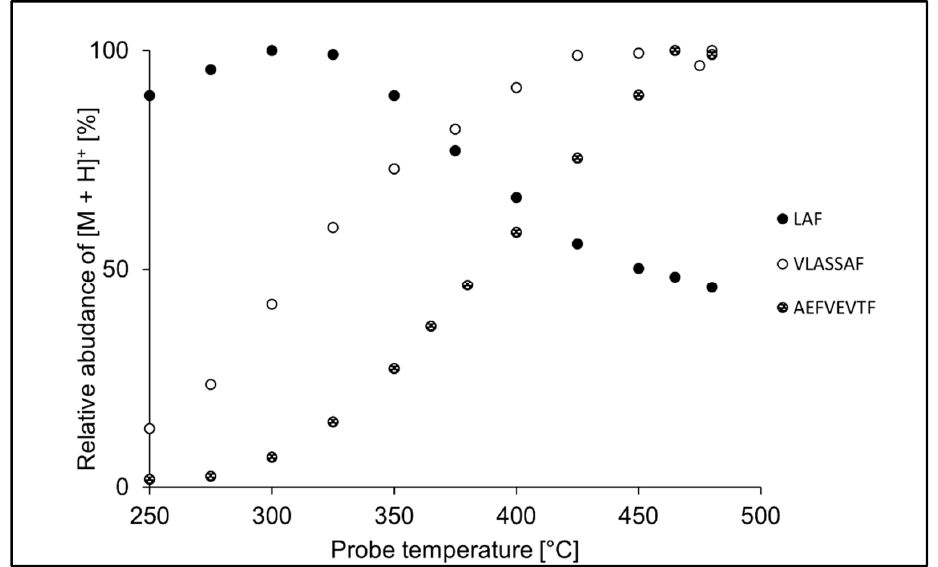
Figure 3. Effect of the probe temperature in APPI on the relative intensity of LAF, VLASSAF, and AEFVEVTF. The values are normalized to the highest intensity of the protonated molecule ([M + H] + ) in the respective peptide.